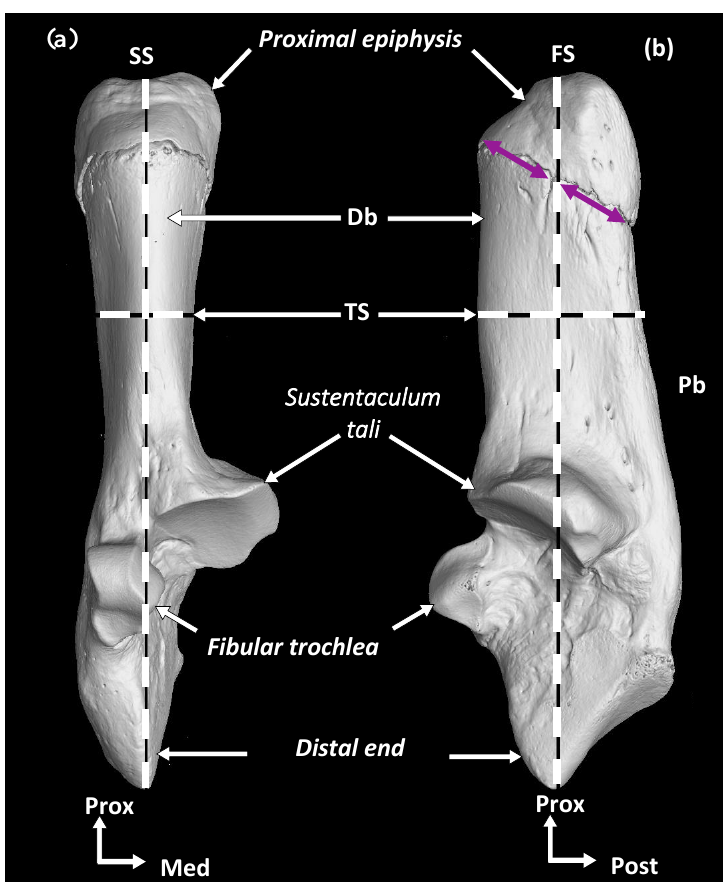
Figure 2: Calcaneus of Sus scrofa, specimen 2017-578 illustrating the planes of the virtual sections: SS, Sagital section; FS, Frontal section; TS, Transverse section. Db, Dorsal border; Pb, Plantar border. Purple arrows indicate the midpoint of the proximal epiphysis